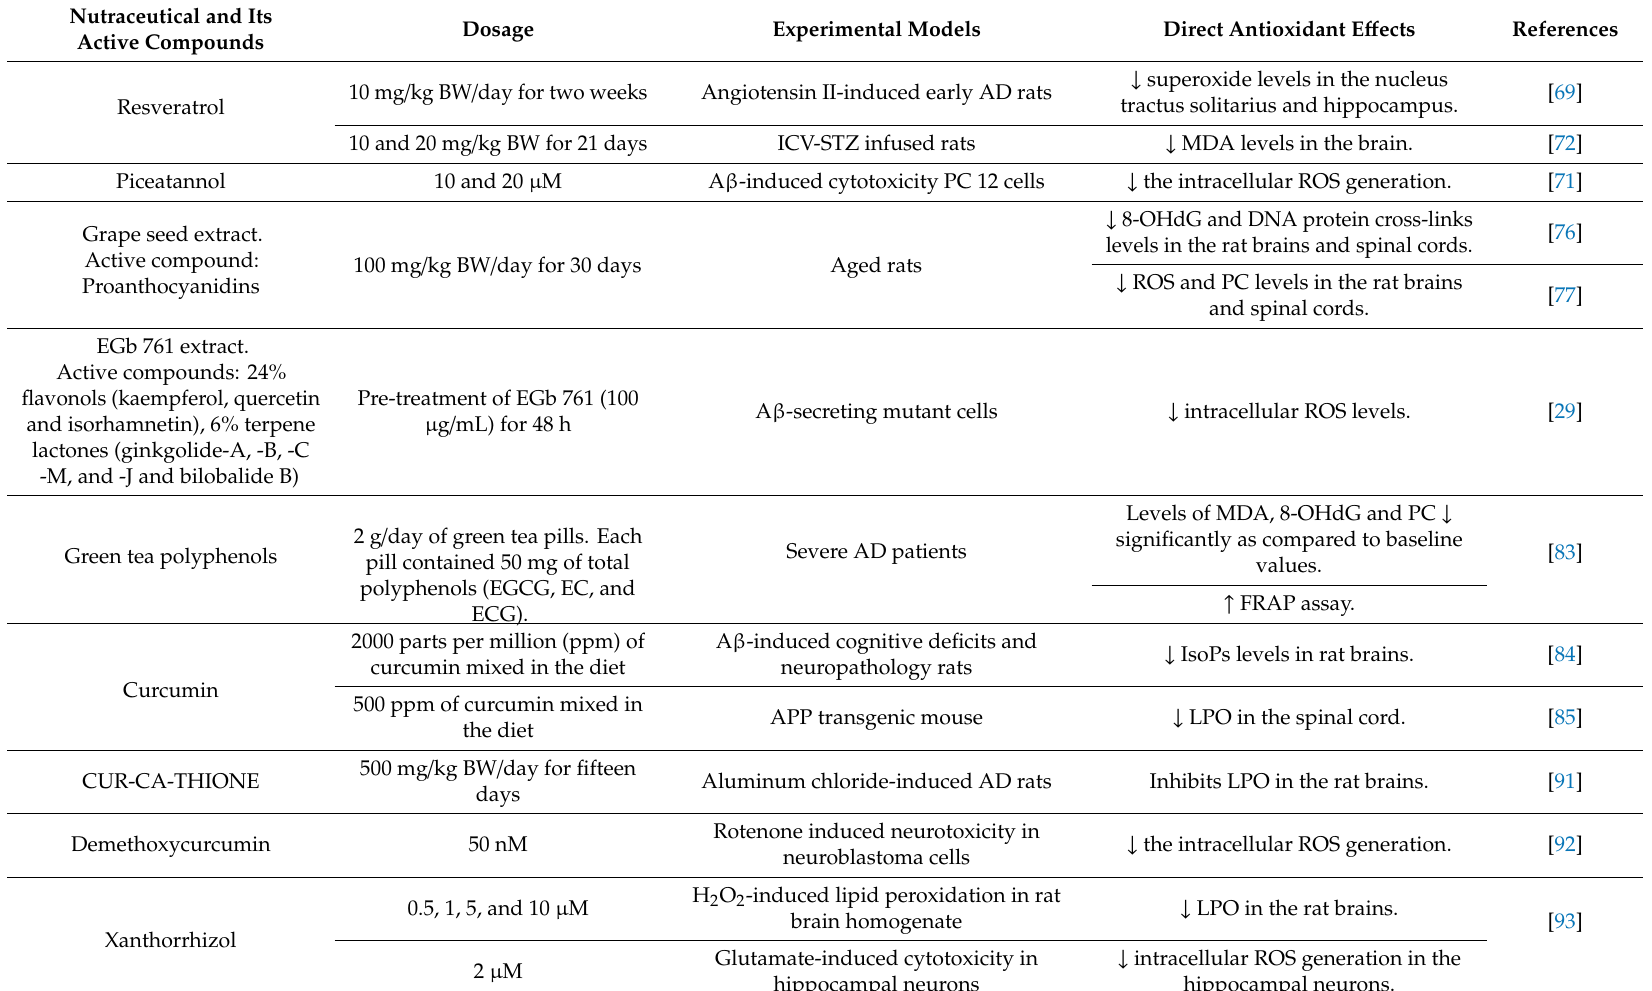
Table 1. Direct antioxidation properties of